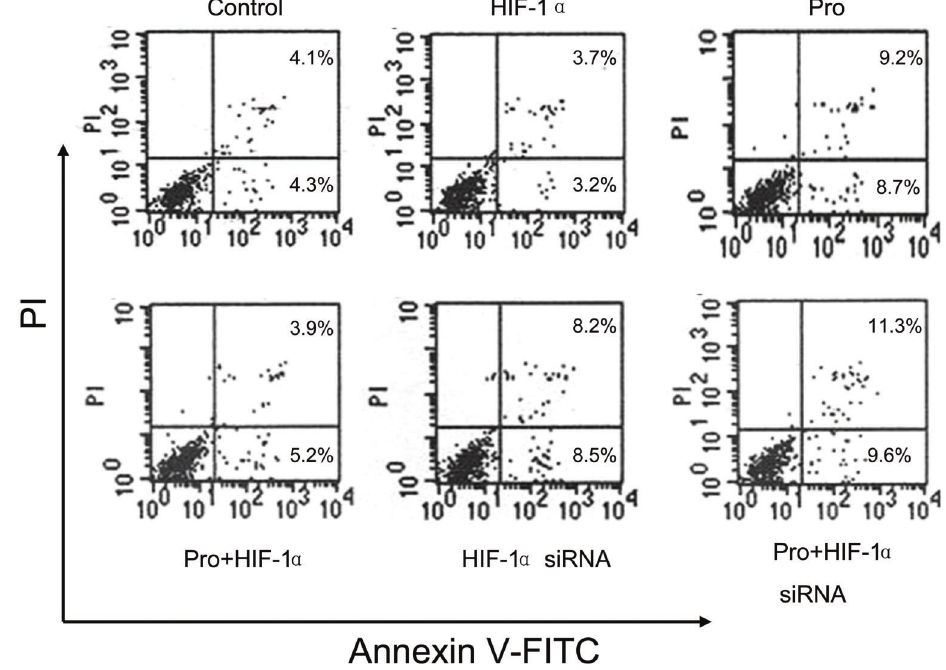
Figure 4. Overexpressed hypoxia inducible factor-1 a (HIF-1 a ) hemangioma cells and knockdown hemangioma cells were treated or not with 50 m M propranolol (Pro) for 48 h. Cell apoptosis was determined by annexin V-FITC. Representative images of cell apoptosis are shown for each group. PI: propidium iodide